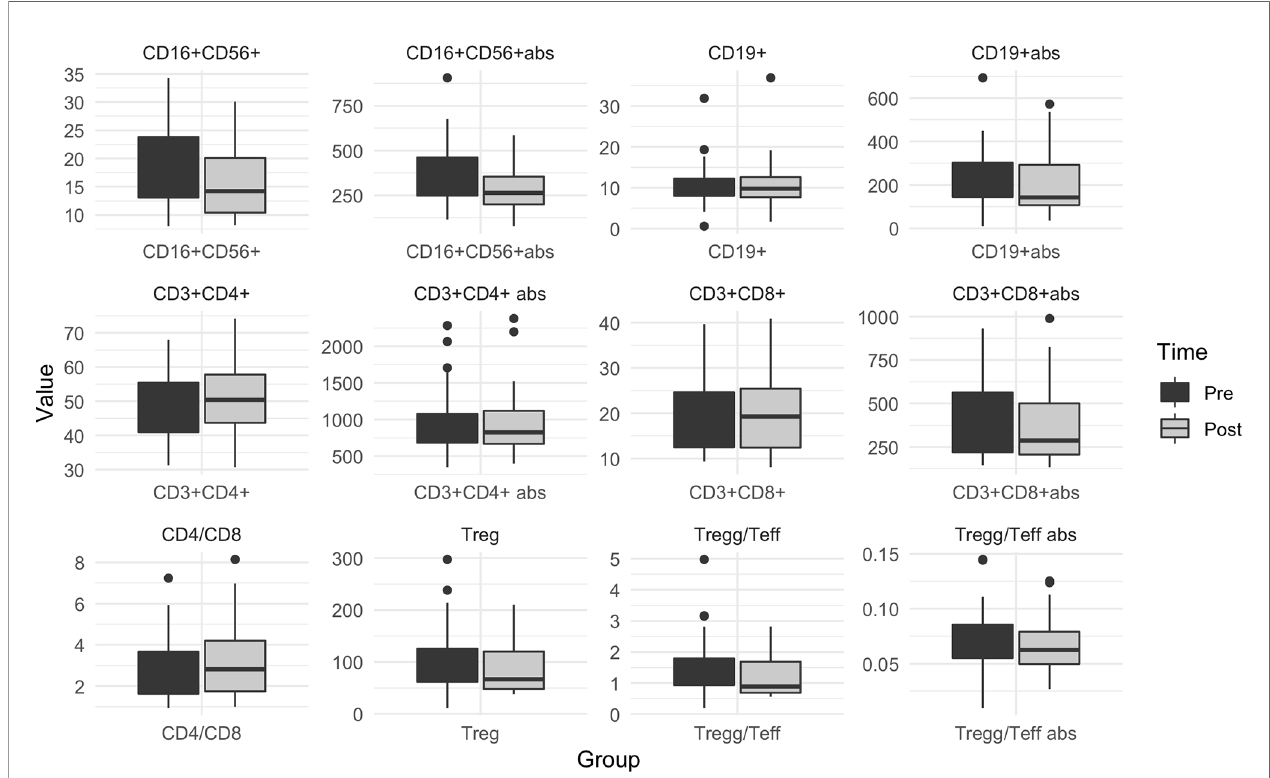
FIGURE 4 | Box plot for pre/post olaparib circulating immune cells levels in the overall population. Pre: before olaparib; Post: after 3 weeks of olaparib; Abs, absolute count. When abs not speci fi ed, the graphic is referred to %. Treg, Regulatory T lymphocytes; Teff, Effectors T